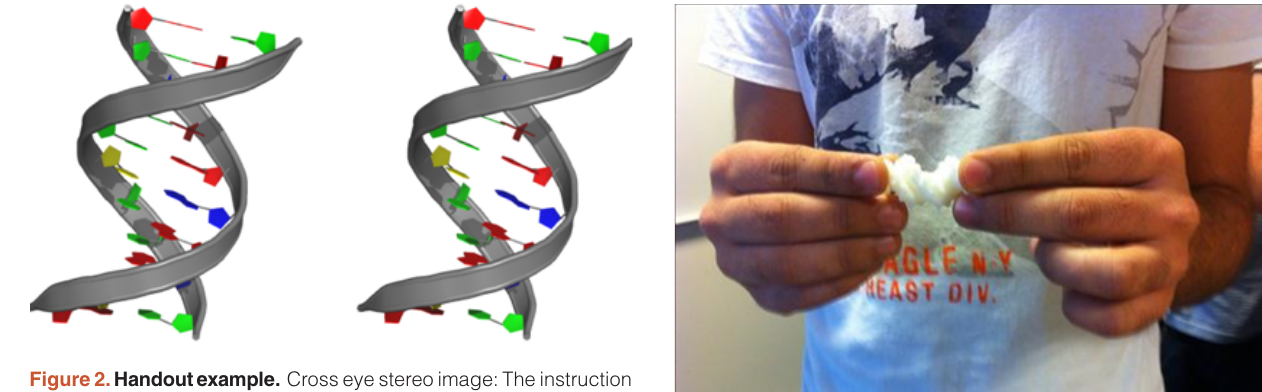
Figure 2. Handout example. Cross eye stereo image: The instruction to students was to gaze at the stereo pair, keeping your eyes level (don’t tilt your head left or right), and cross your eyes slightly so that the two images in the centre come together. When they converge or fuse, you will see them as a single 3D image.